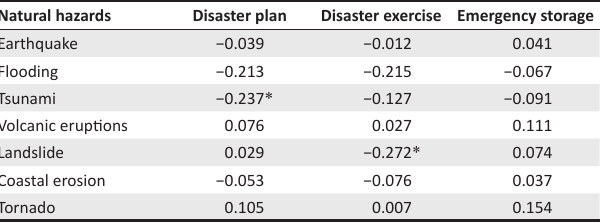
TABLE 7: Summary of correlation results of readiness activities and natural hazards. Natural hazards